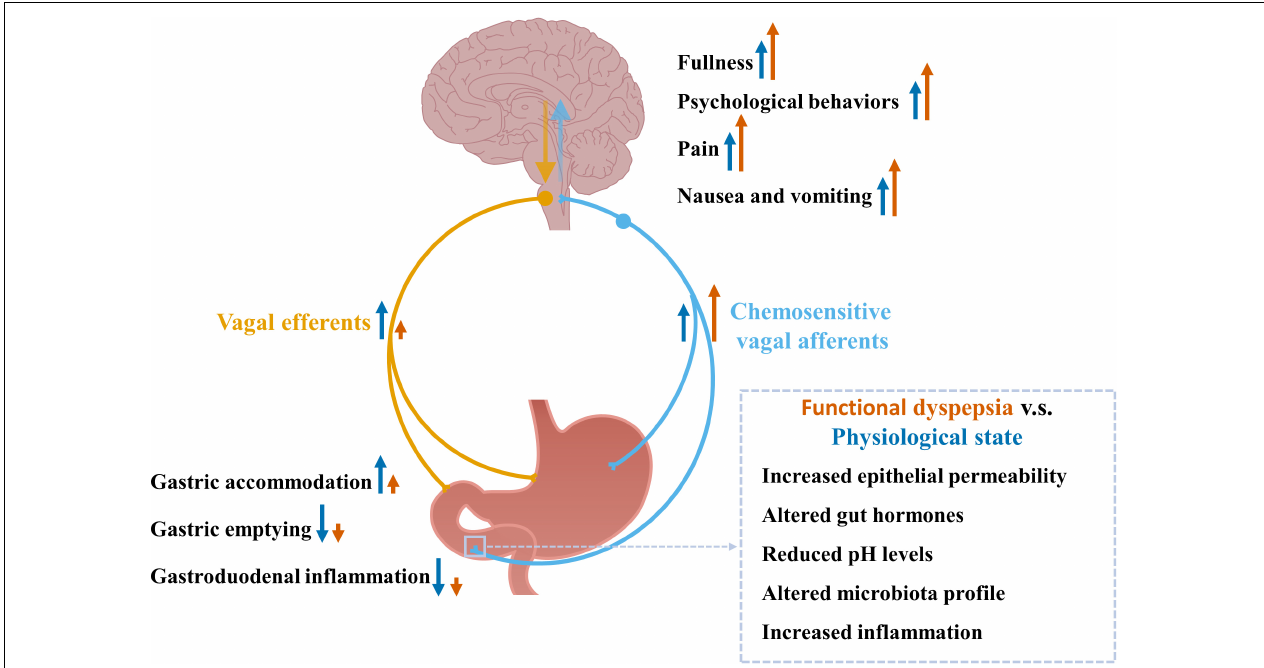
FIGURE 2 | Chemosensitive vagal afferent signaling in response to altered chemical stimuli observed in functional dyspepsia and the associated pathophysiological changes. Chemosensitive vagal afferents can sense chemical stimuli including nutrients, gut hormones, pH levels, and inflammation-associated factors. These signals are sent to the brain via vagal afferents where the information is processed leading to increased fullness, psychological behaviors, pain sensation, nausea, and vomiting, as well as reflex signals back to the gut, via vagal efferents, leading to increased gastric accommodation and reduced gastric emptying. Functional dyspepsia is associated with increased gastroduodenal permeability, infiltration of eosinophil and mast cells, altered microbiota profile and increased chemical stimuli, which may enhance vagal afferent signals to the brain contributing to the increased feelings of fullness, psychological behaviors, pain sensation, nausea and vomiting observed in functional dyspepsia. The chemical stimuli induced vagovagal reflex is impaired in functional dyspepsia (Feinle et al., 2001; Schwartz et al., 2001), which may lead to impaired gastric accommodation, and impaired inhibition on gastric emptying and gastroduodenal